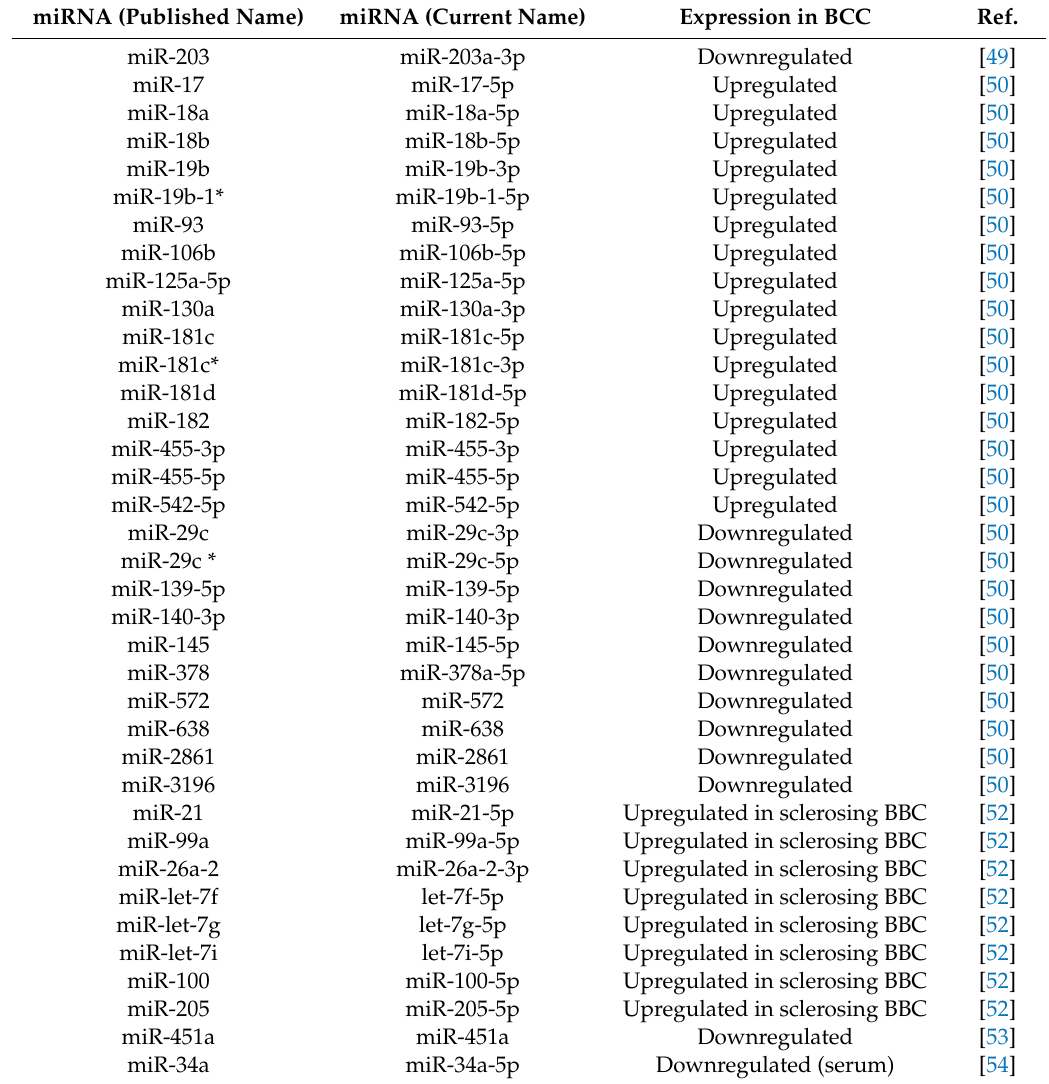
Table 1. MiRNAs dysregulations reported in basal cell